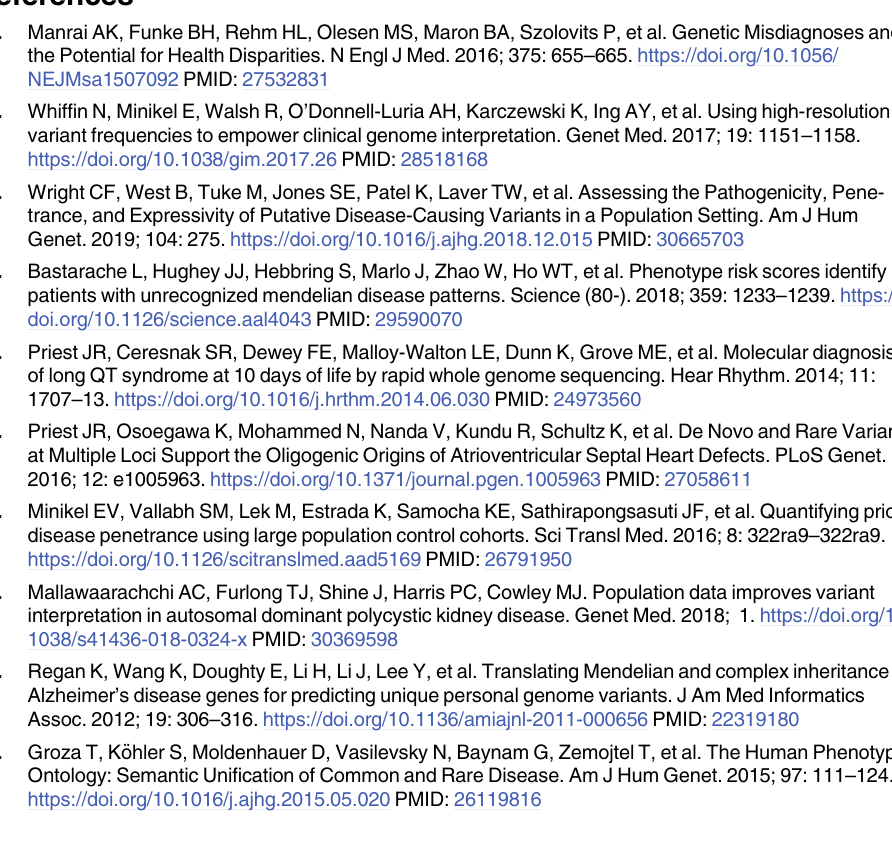
S7 Fig. Correlation plot between minor allele frequency and absolute value of beta for the subset of significant variant. The color indicates variant in each gene and the shape indicates each phenotype (ex: variants in PTPN11 are represented in blue, and the association with hypercholesterolemia with the sign +). (a) set of variants with MAF < 0.01, (b) set of variant with MAF between 0.01 and 0.5 (c) full set of significant